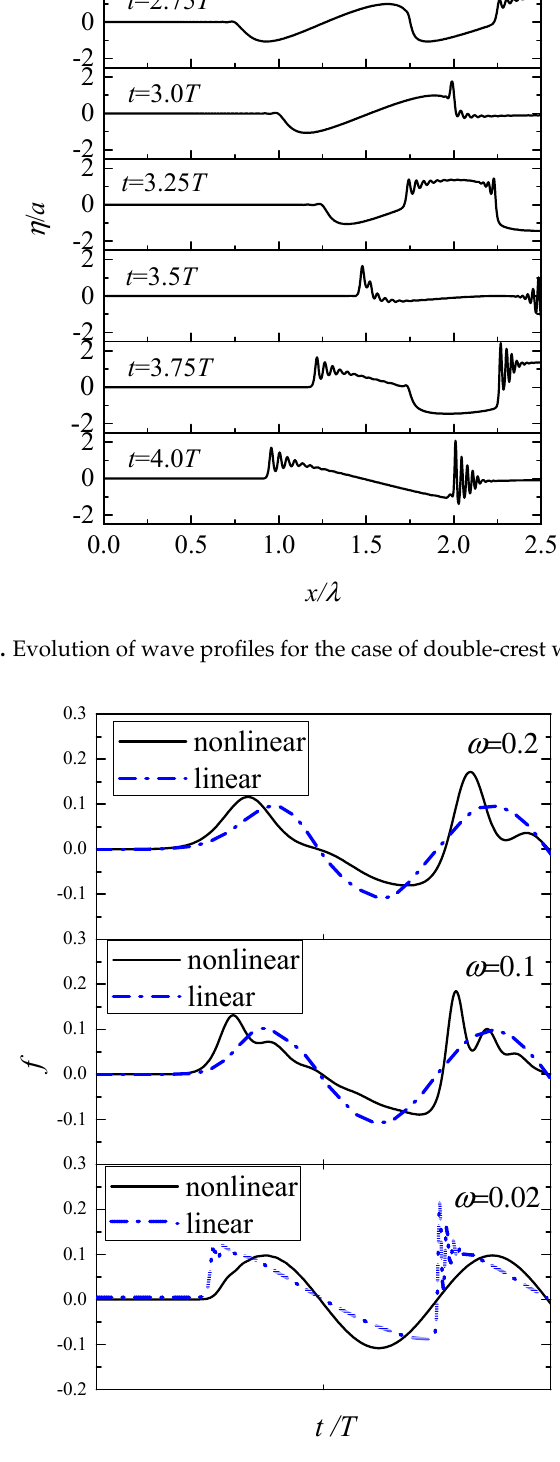
Figure 10. History of wave force acting on the vertical seawall for double-crest wave train of different wave frequencies.